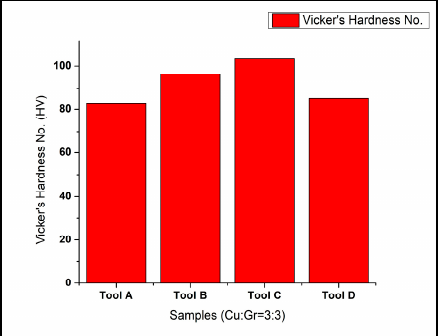
Figure 10. Vicker’s hardness number (HV) of the composites prepared by Tools A, B, C, D.